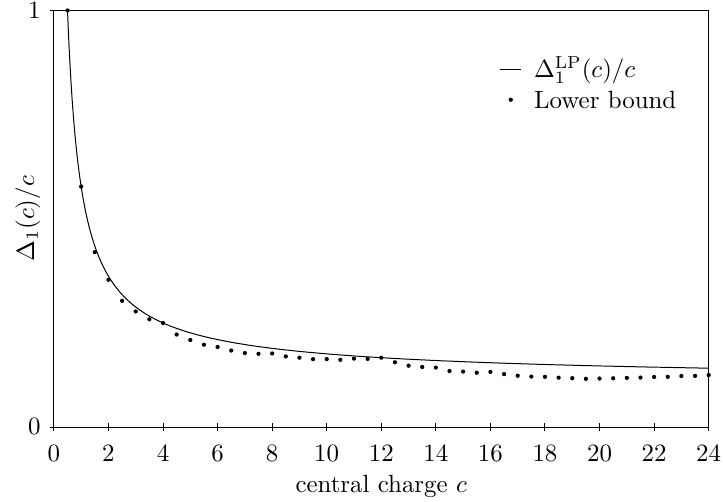
Figure 2 . The ratio ∆ LP ( c ) /c , together with lower bounds from sphere packings. 1